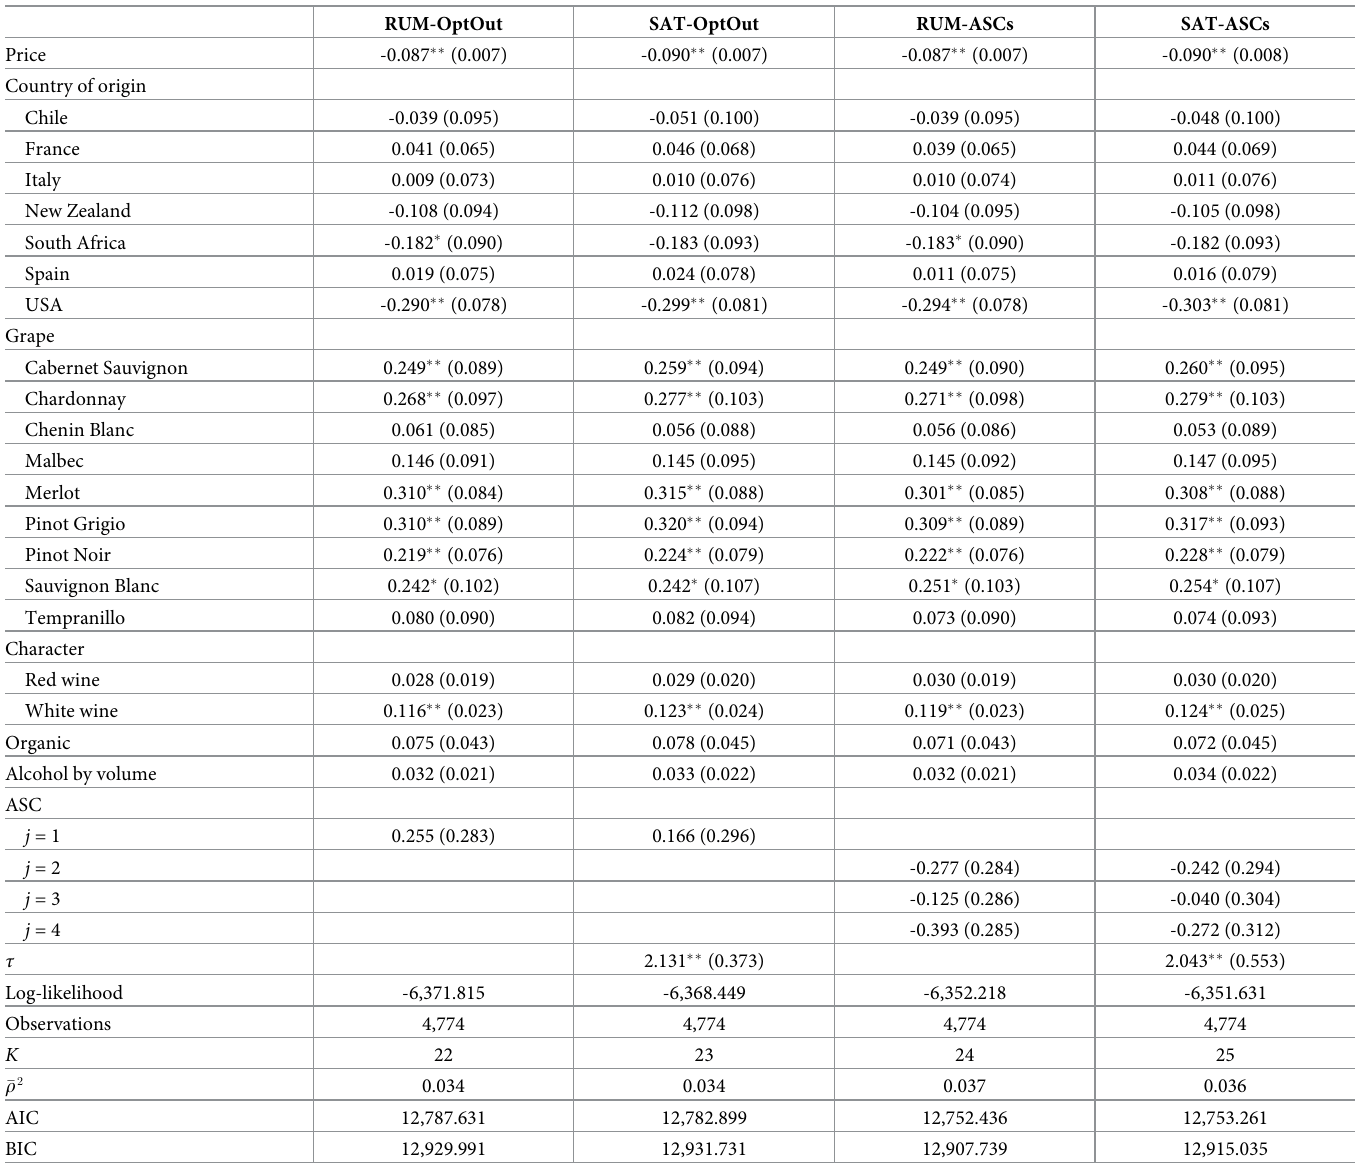
Table 4. Estimation results for treatment